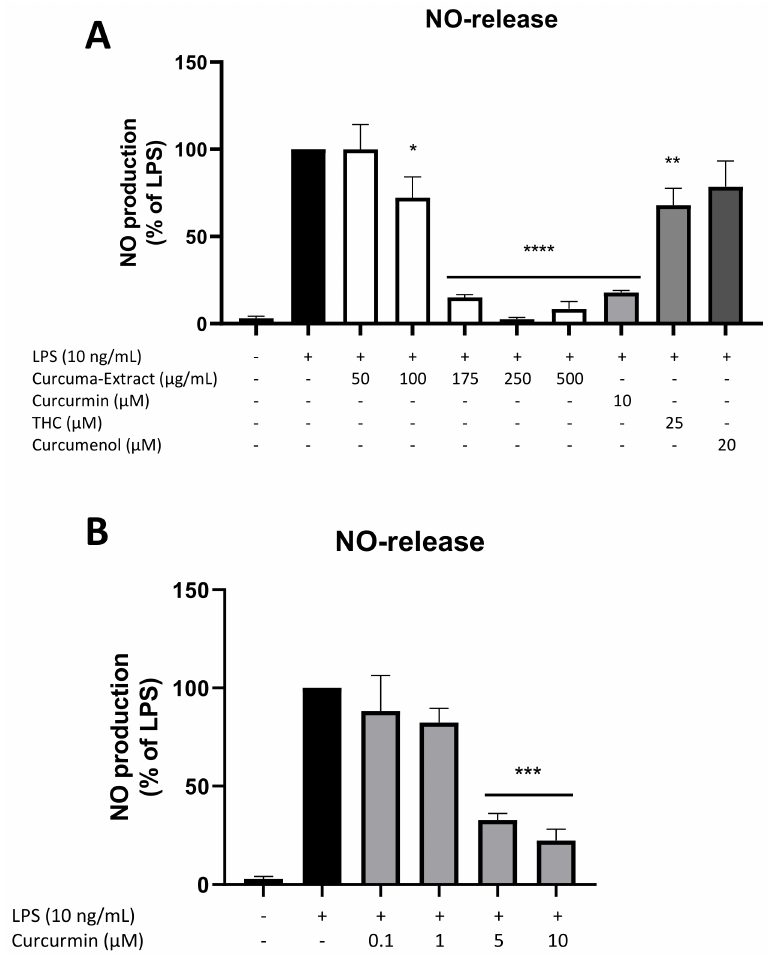
Figure 2. Effects of different concentrations of TE and its constituents curcumin, THC, and curcumenol (one single high dose, respectively) ( A ), and different doses of curcumin ( B ), on NO-release in LPS- stimulated BV2 cells. The substances were added 30 min before stimulation with 10 ng/mL LPS. NO-release was measured as described below. Values are presented as the mean ± SEM of at least three independent experiments. Statistical analysis was performed using one-way ANOVA with Bonferroni post hoc tests and * p < 0.05, ** p < 0.01, *** p < 0.001, and **** p < 0.0001 compared to